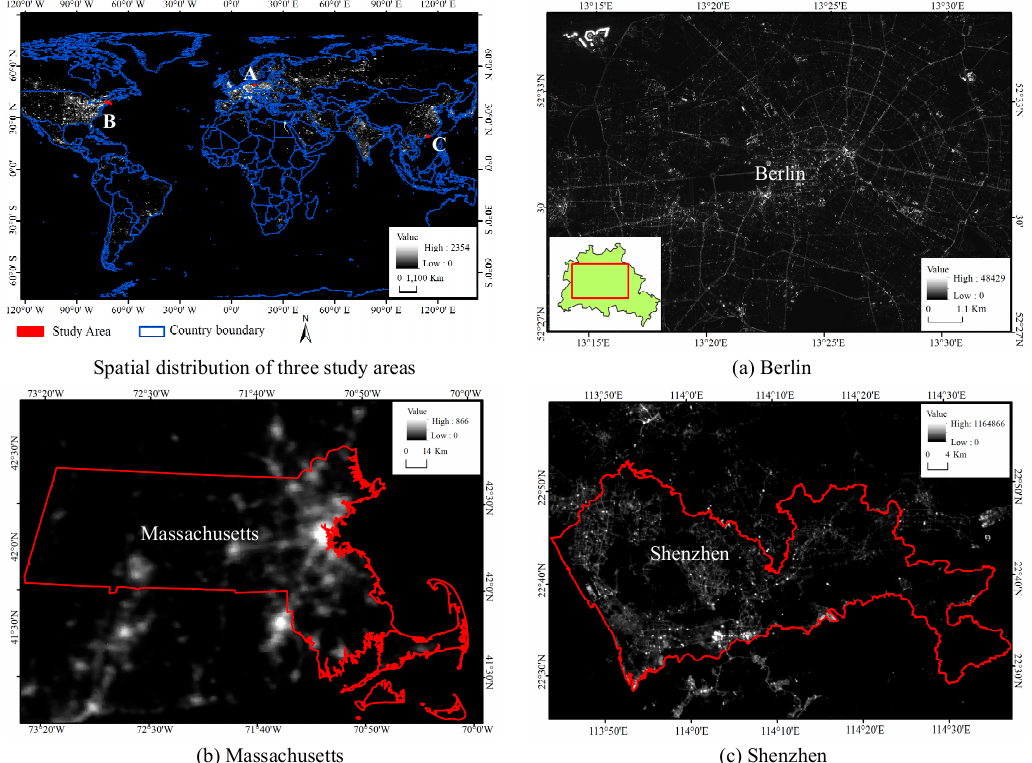
Figure 2. Three selected study areas: Berlin, Massachusetts and Shenzhen.